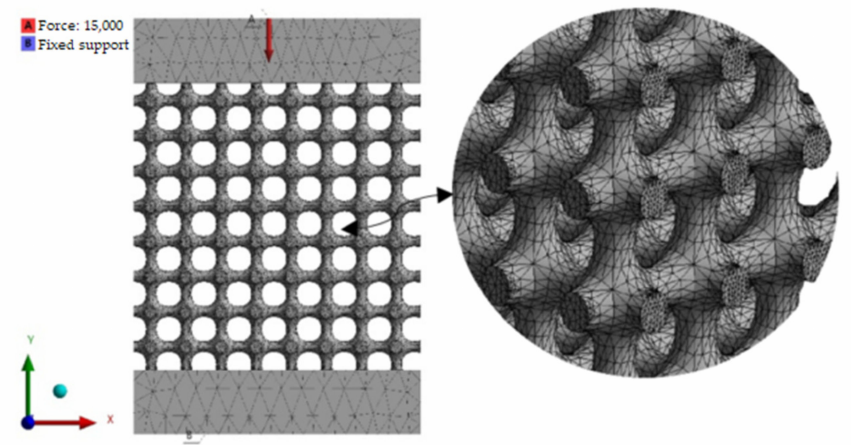
Figure 4. Simulation parameters of the compression